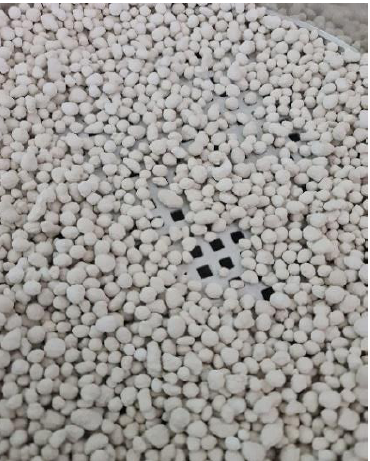
Figure 1. Gypsum granules during sieving through successive sieves.